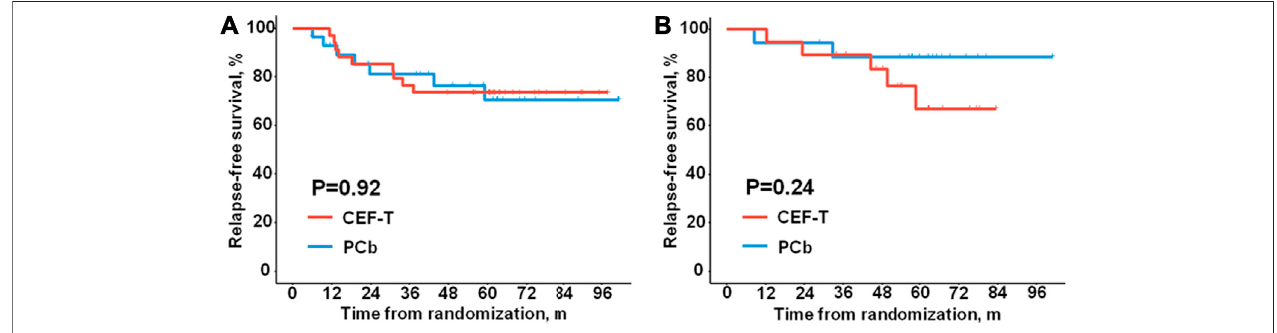
FIGURE3| Relapse-freesurvivalofdifferenttreatmentcohorts.Kaplan-Meierplotsshowrelapse-freesurvivalof (A) thepatientswith “ coldtumor ” , (B) thepatients with “ hot tumor ” . CEF-T indicates fl uorouracil, epirubicin, and cyclophosphamide, followed by docetaxel; PCb, paclitaxel and